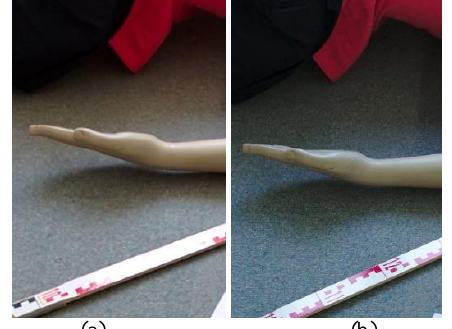
Figure 9. Comparison of dynamic range of (a) Lytro vs (b) DSLR The staff (bottom left) is overexposed in the Lytro image while the dark corner does not show any detail. The Nikon image shows both staff markings and detail within the dark